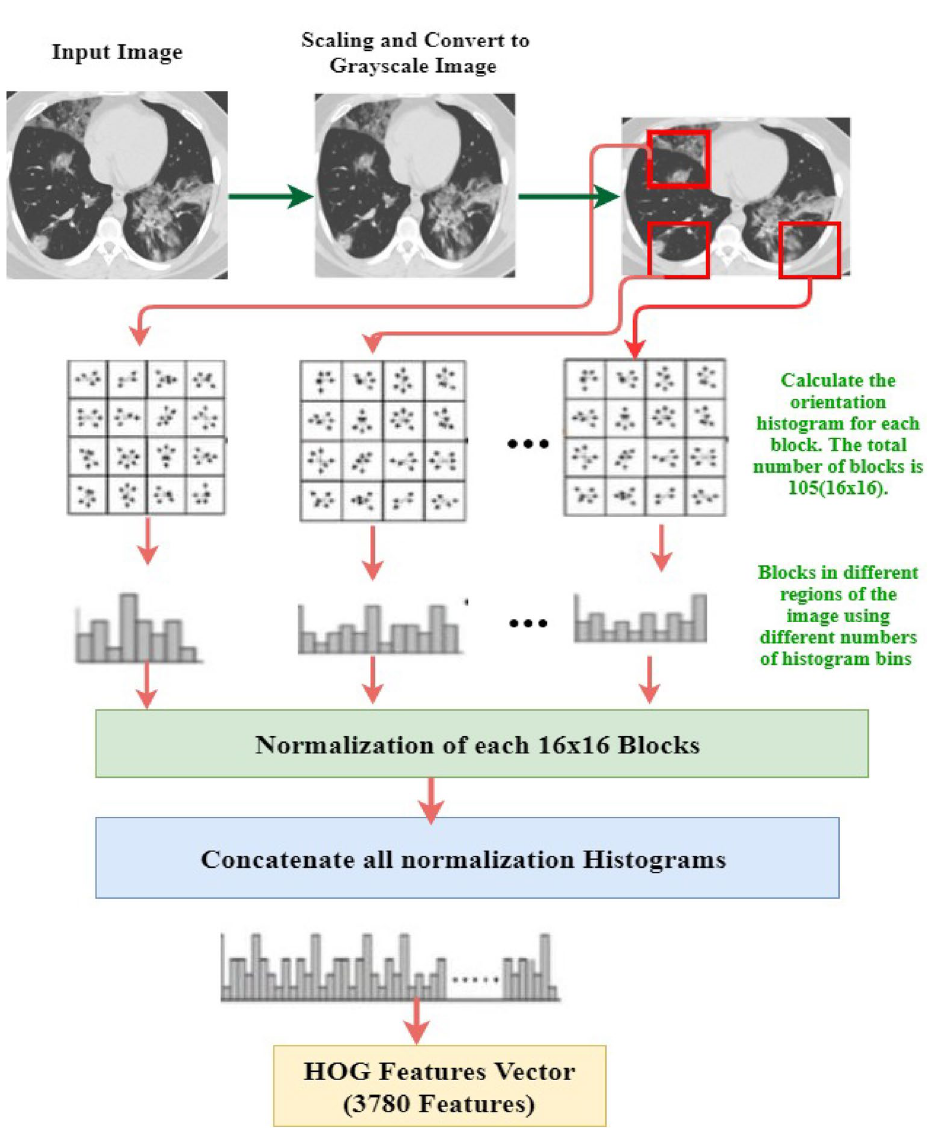
Figure 6. Architectural representation of histogram oriented gradient features extraction